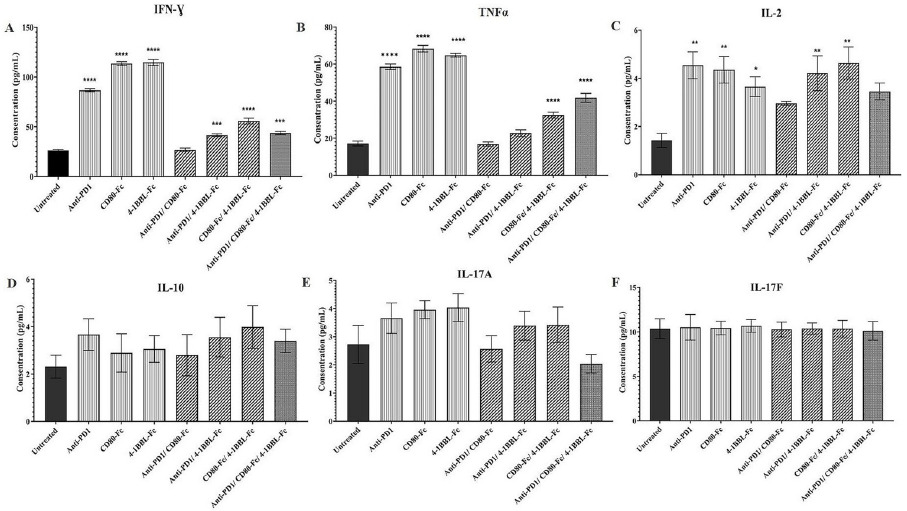
Fig 4. Potential of mono and combination treatments of anti-PD-1, CD80-Fc, and 4-1BBL-Fc proteins on cytokine release. An allogeneic MLR was performed and supernatants were harvested on day 4 for cytokine analysis in triplicates. This figure shows concentration of 6 cytokines: (A) IFN- γ (B) TNF- α (C) IL-2 (D) IL-10 (E) IL-17A (F) IL- 17F. Data is reported as mean ± SEM ( � p � 0.05, �� p � 0.01, ��� P � 0.0001, ���� P � 0.0001).